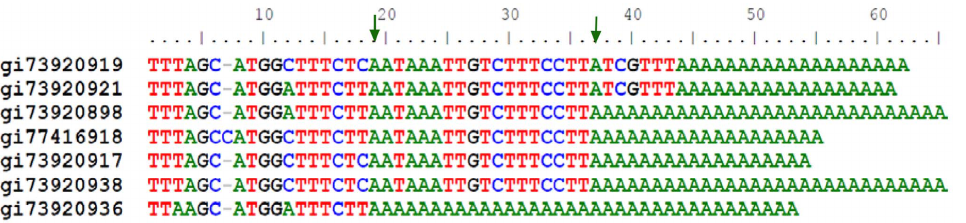
Figure 1. The alignment of 3 9 -end sequences of potato Kunitz-type protease inhibitor messenger RNAs. Note that each polyadenylation [poly(A)] tail likely starts from an adenosine (as indicated by the arrows).